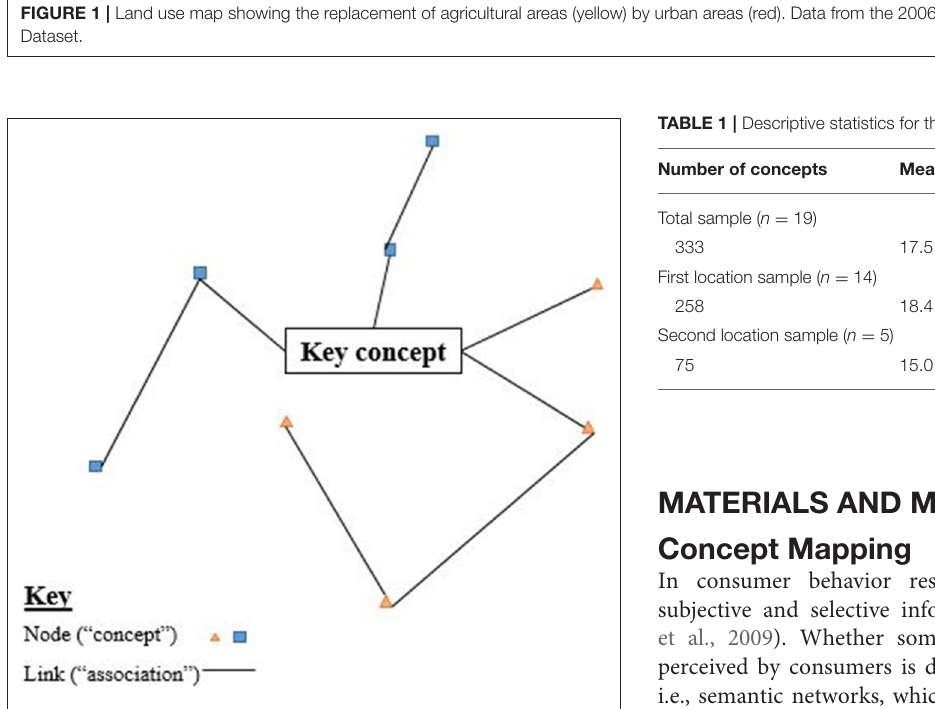
FIGURE 2 | Illustrative figure of a semantic network.